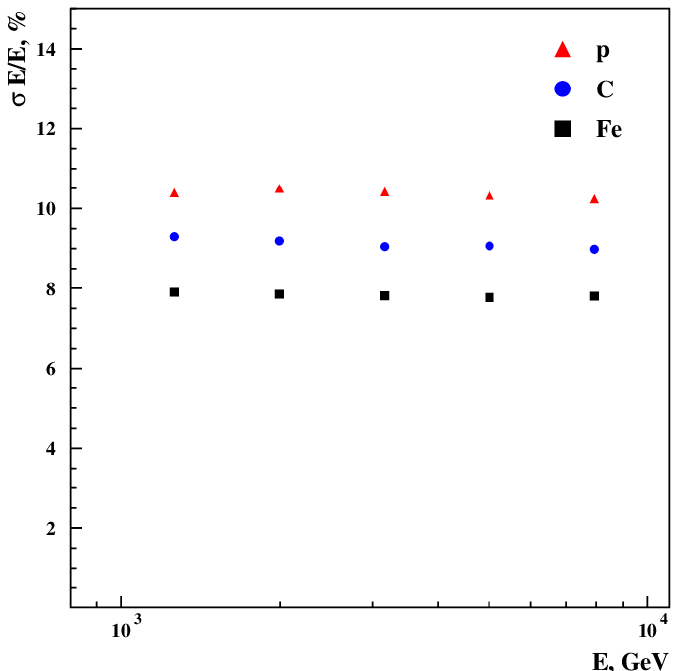
Figure 4. Energy resolution for p, C and Fe cascades at different energies in the PAMELA calorim- eter.